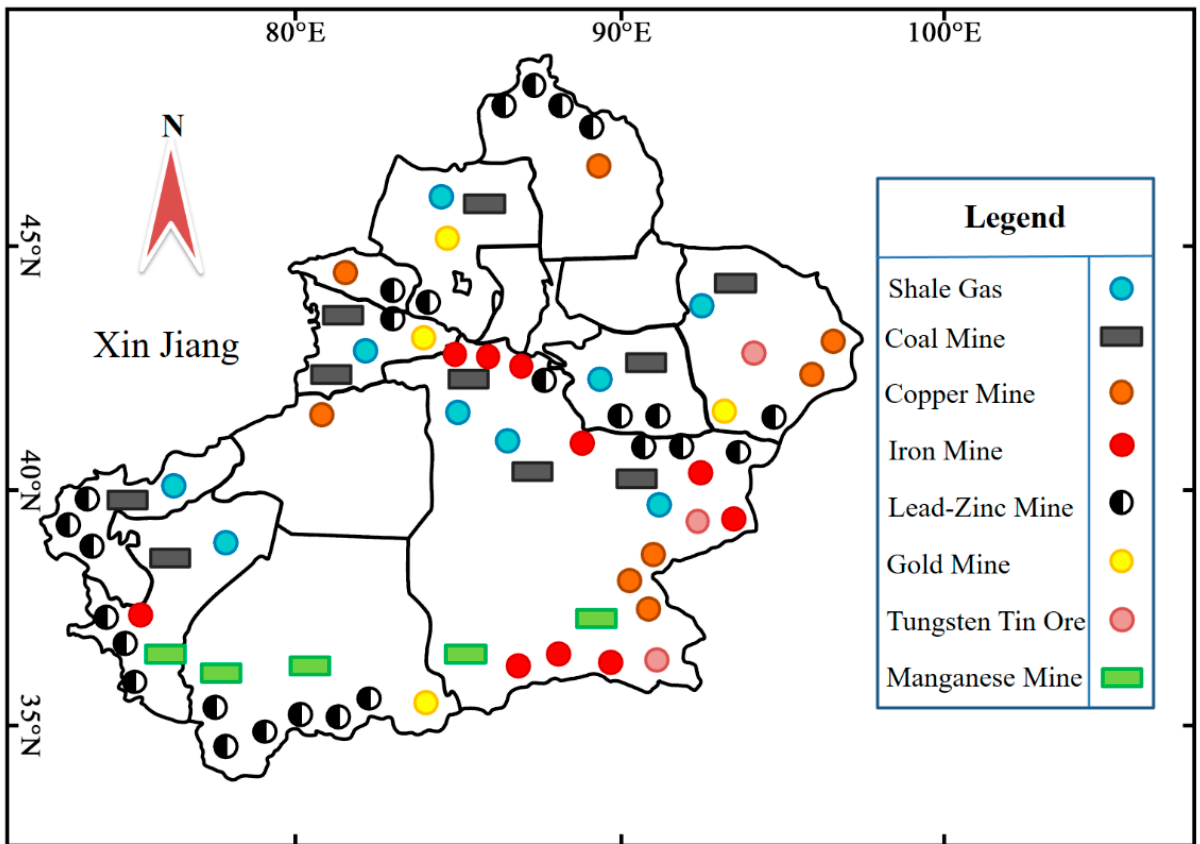
Figure 2. Distribution of the mineral resources in Xinjiang province.